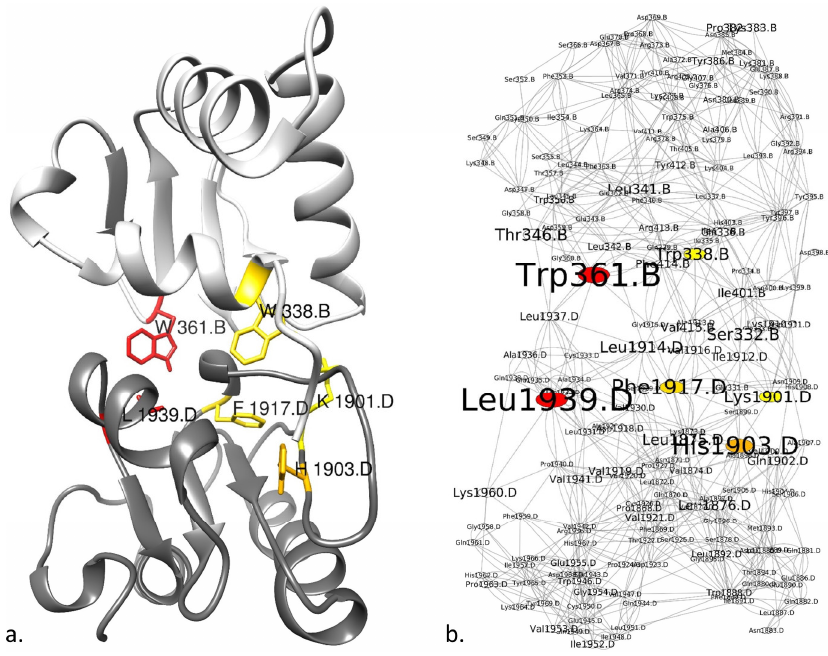
Figure A1. Residue Centrality Analysis (RCA) performed on the Residue Interaction Network (RIN) generated from the best docking pose of the ETS domain of Ets-1 (PDB ID: 1GVJ) and the second BRCT domain of TP53BP1 (PDB ID: 1GZH). ( a ) Structure of the best docking pose calculated by ClusPro; at the top in light grey is ETS(Ets-1); at the bottom in dark grey is BRCT(TP53BP1); central residues at the interface are depicted with atomic side chains in a gradient of color from yellow (Z-score = 2) to red (Z-score ≥ 4); ( b ) RIN generated from the structure ( a ); central residues are those depicted in ( a ) with the same color code, the bigger the node and label sizes, the higher the Z-score, other nodes are white.